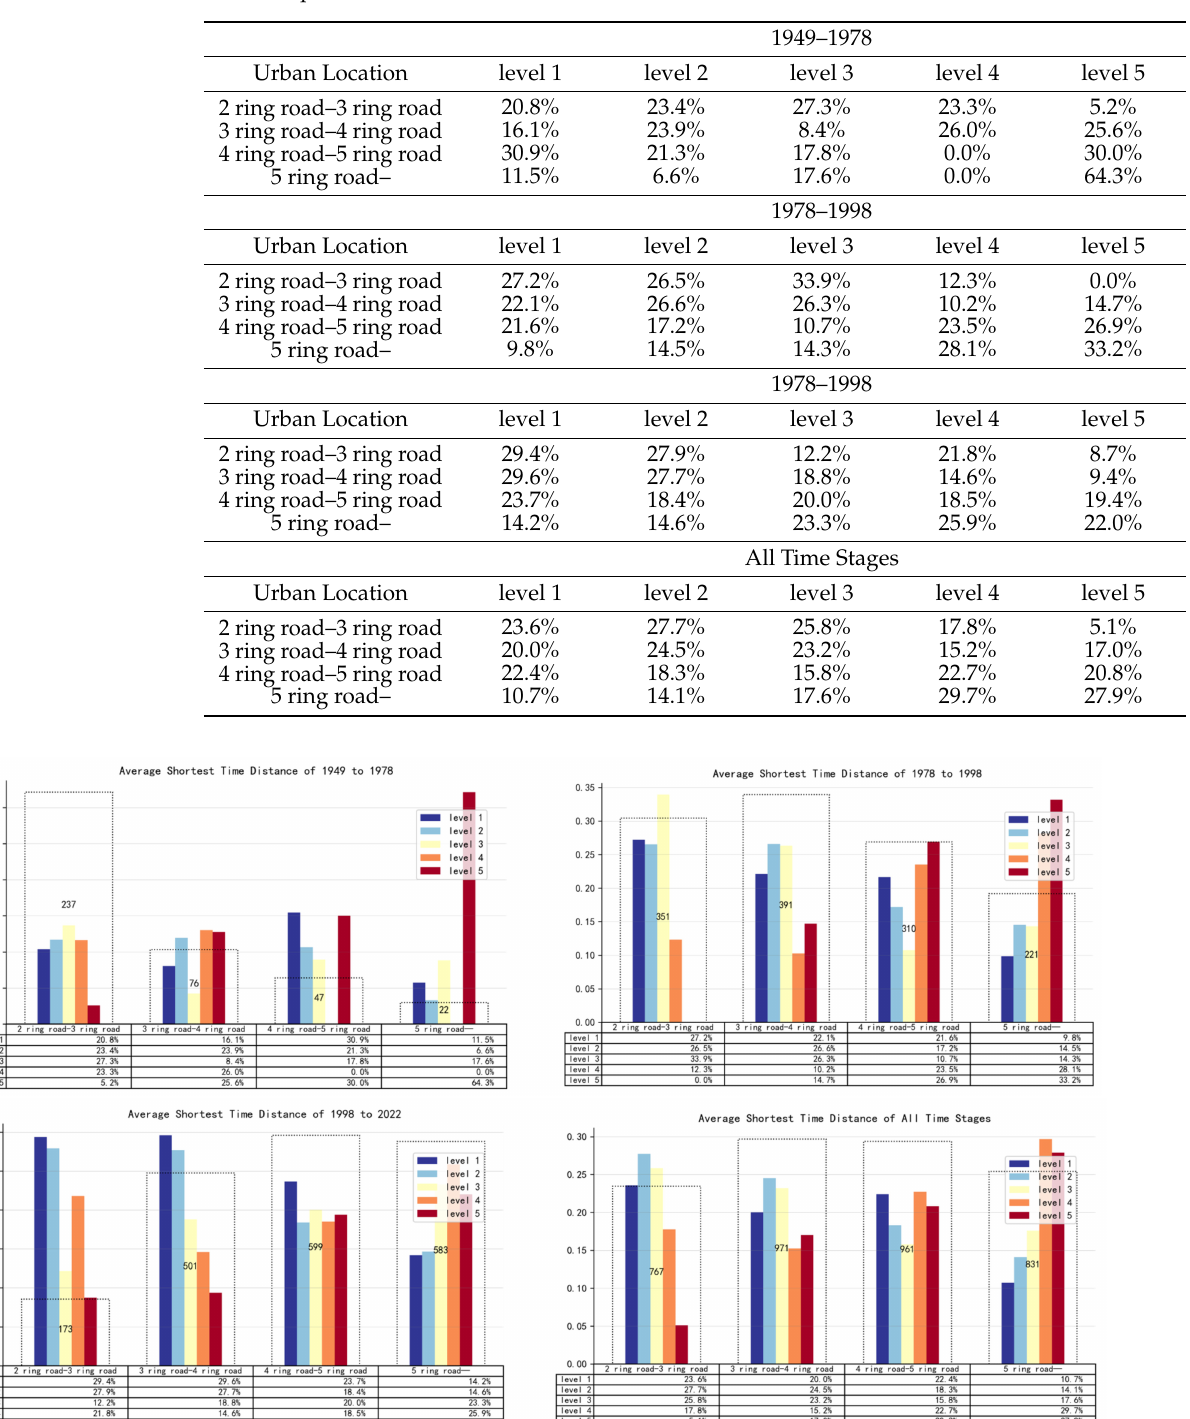
Table 4. Specific measurement results of the Shortest Time Distance method.